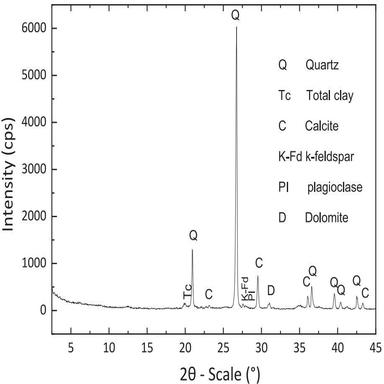
XRD patterns of clayey sample (bulk sample).